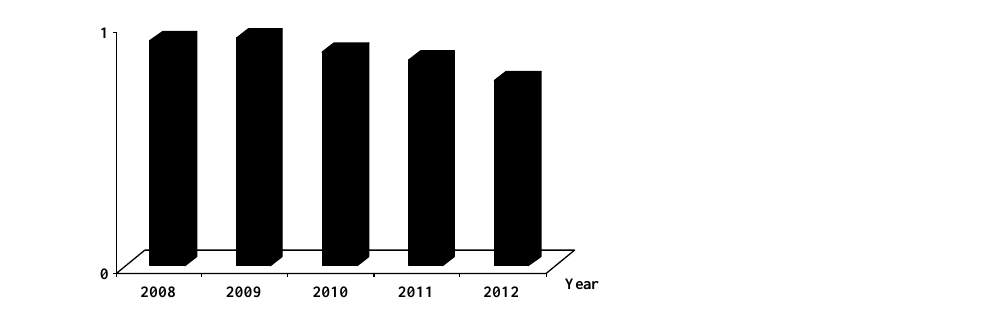
6 of 13 0.0013 allows us to speak about the difference in the average values characterizing the abundance of insects for the corresponding phases of development of winter wheat. For spring wheat, the F-test values for adult wheat thrips were F(3;16) = 14.339; p = 0.00008 and adult predatory and striped thrips: F(3;16) = 3.7226; p = 0.0333F(3;16) = 8.4947; p =